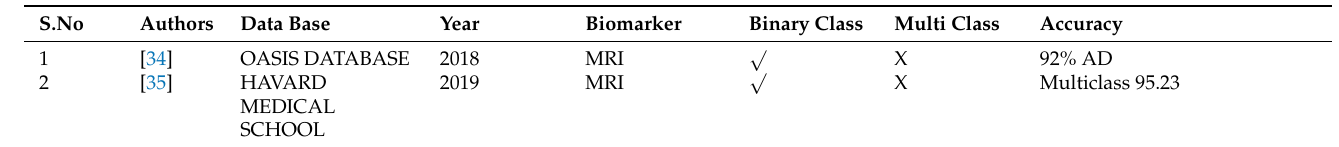
Table 4. Identification of usability of AD biomarkers with reference to accuracy achieved in the different